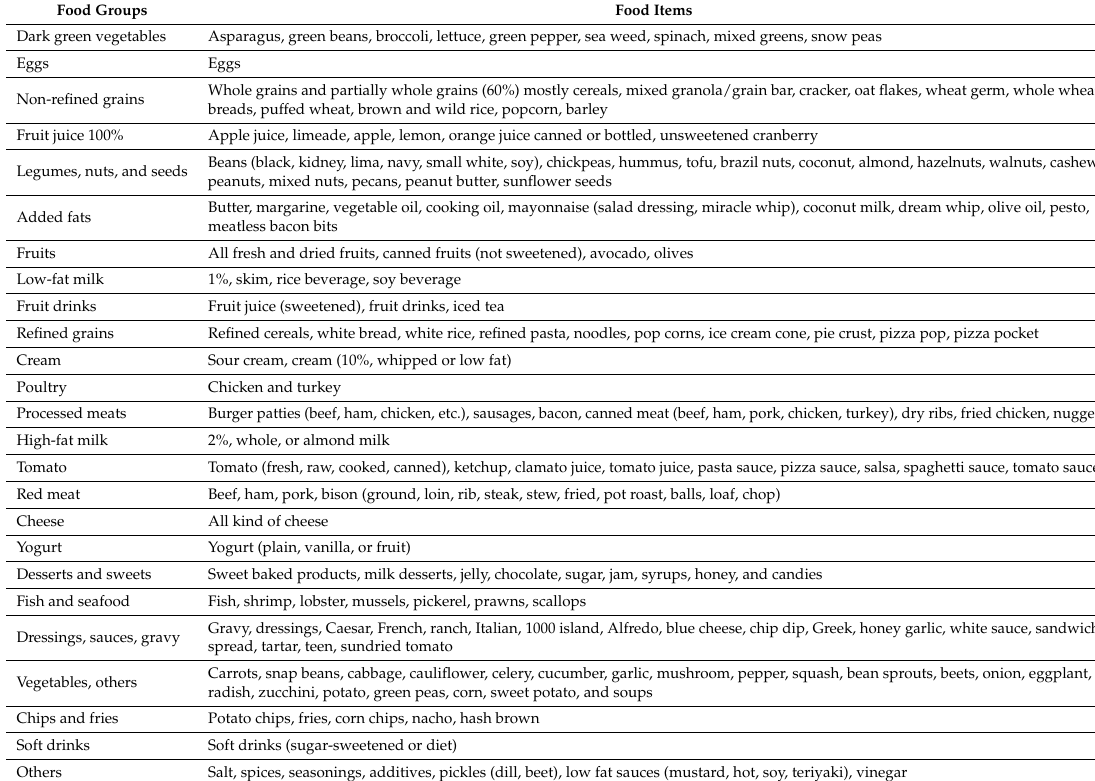
Table 1. Food groups and food items included in principal component